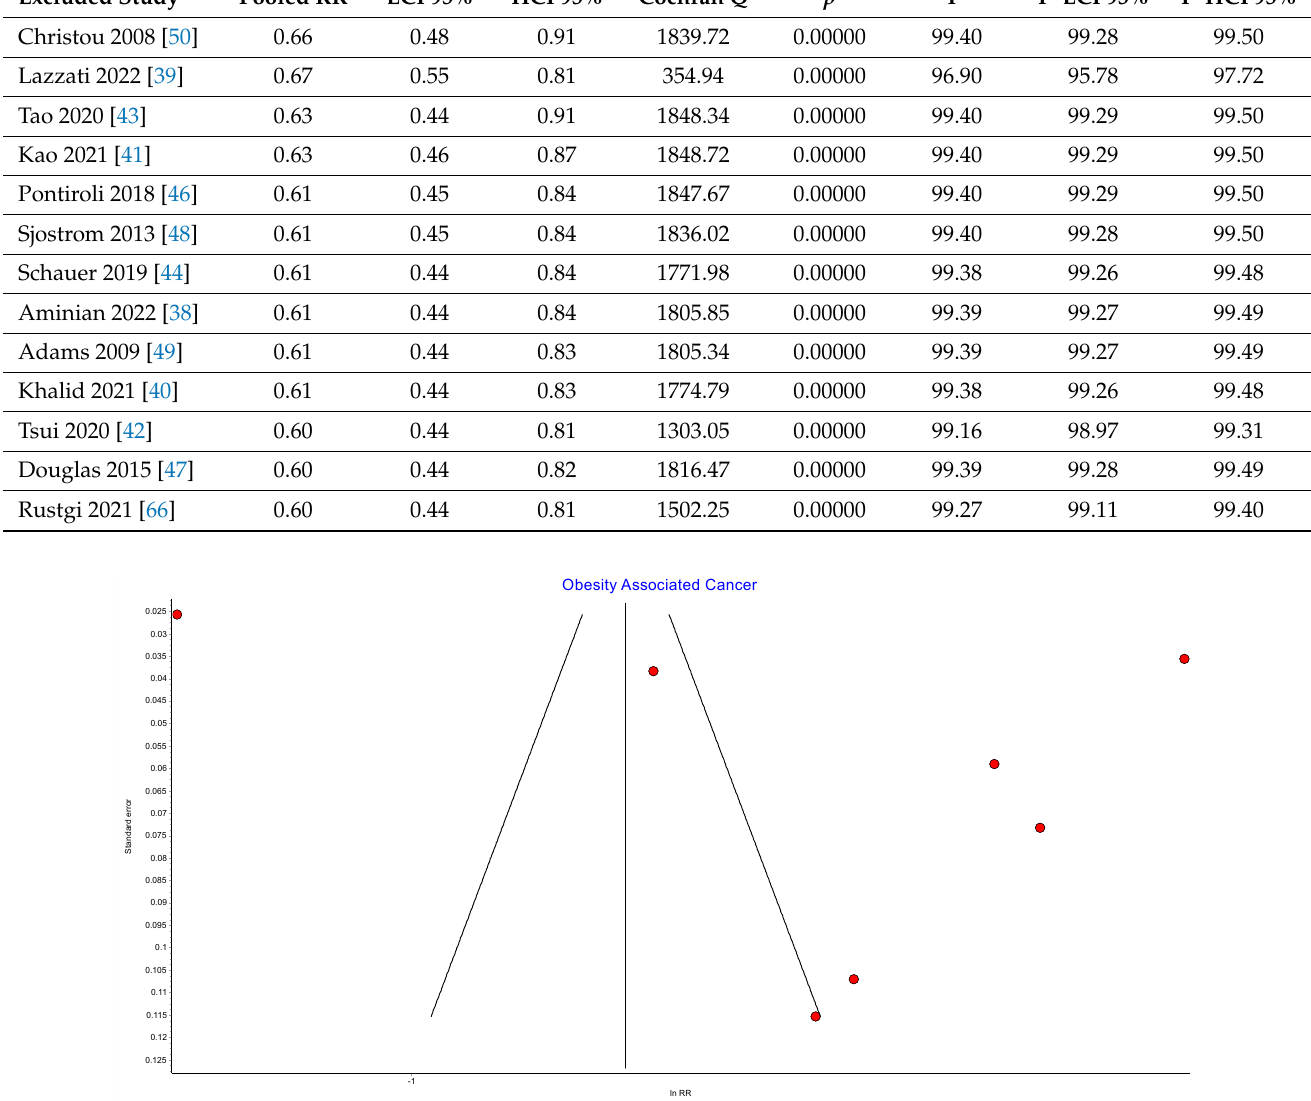
RR-1 ln Figure A2. Incidence of obesity-associated cancers (OAC) RE model funnel plot. Figure A2. Incidence of obesity-associated cancers (OAC) RE model funnel plot. Table A2. Incidence of obesity-associated cancers (OAC) RE sensitivity Table A2. Incidence of obesity-associated cancers (OAC) RE sensitivity analysis.